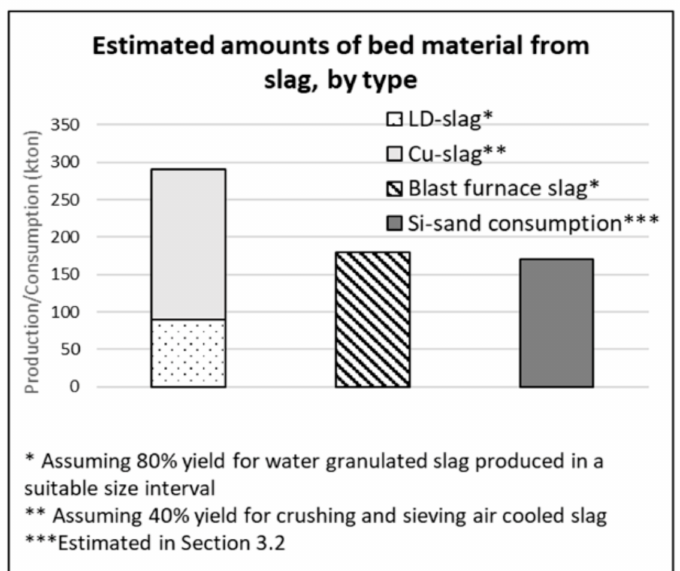
Figure 8. The estimated potential for slag-bed material production compared to estimated current silica sand-bed material consumption. Blast furnace slag is included but is not an oxygen